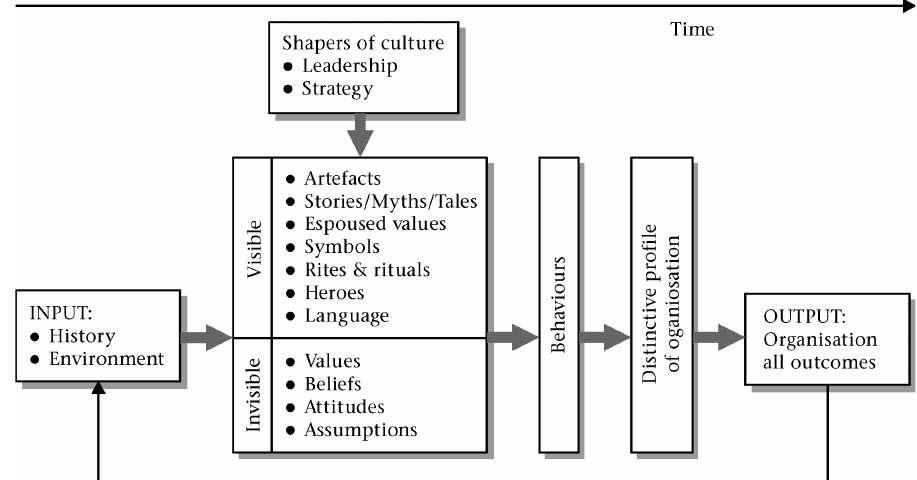
Figure 2: Model of organisational